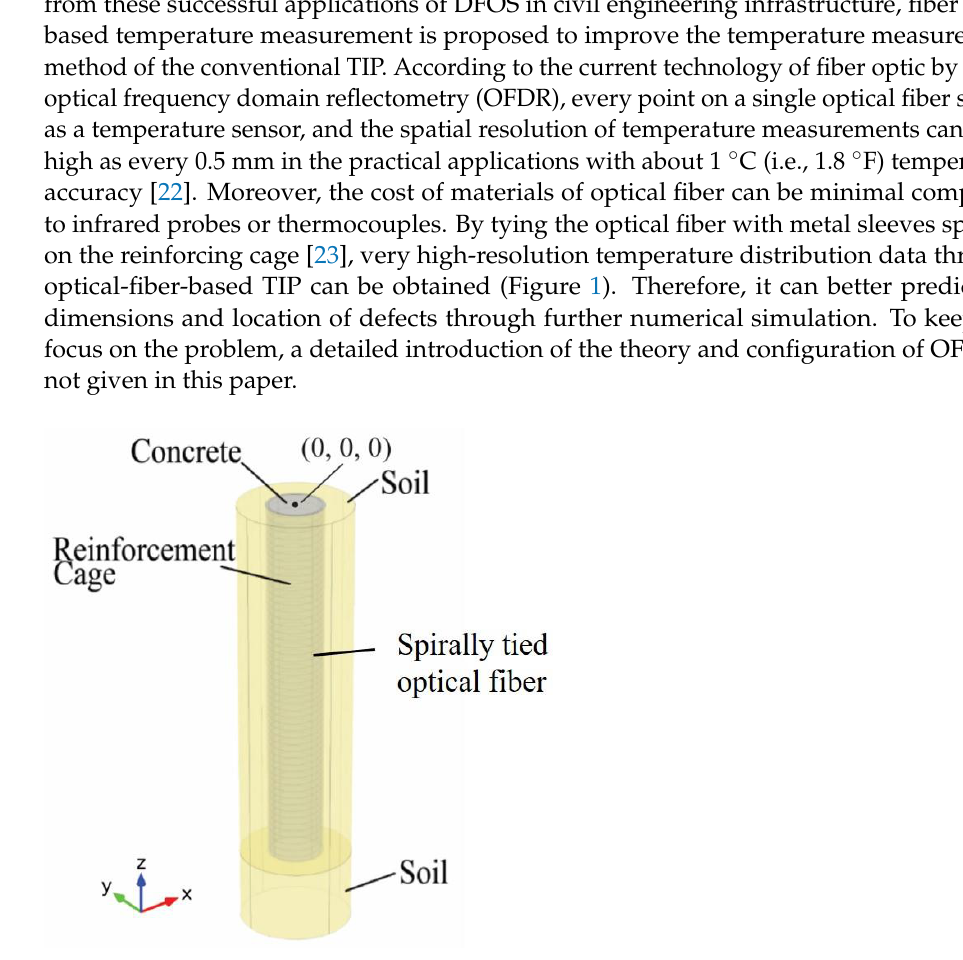
Figure 1. Shaft-soil model with spirally tied optical fiber on the reinforcement cage and surrounded by soil. Figure modified from [23].